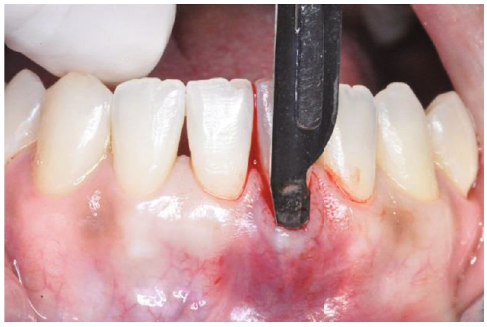
Figure 2: Intrasulcular incision.